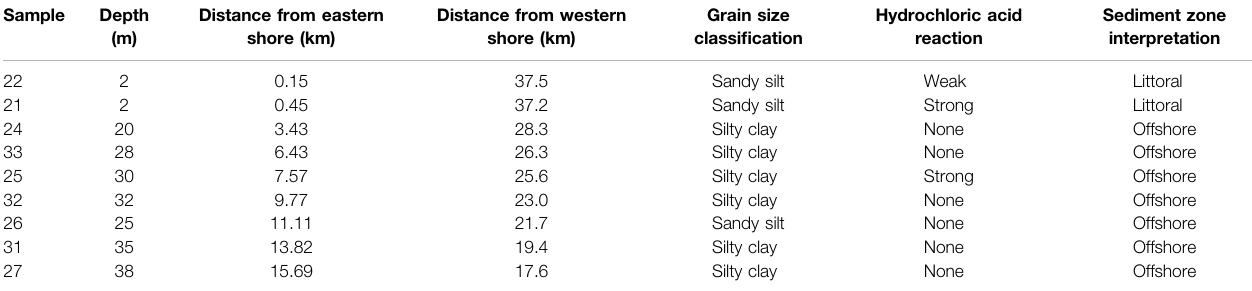
TABLE 1 | Modern Lake Turkana sediment sample